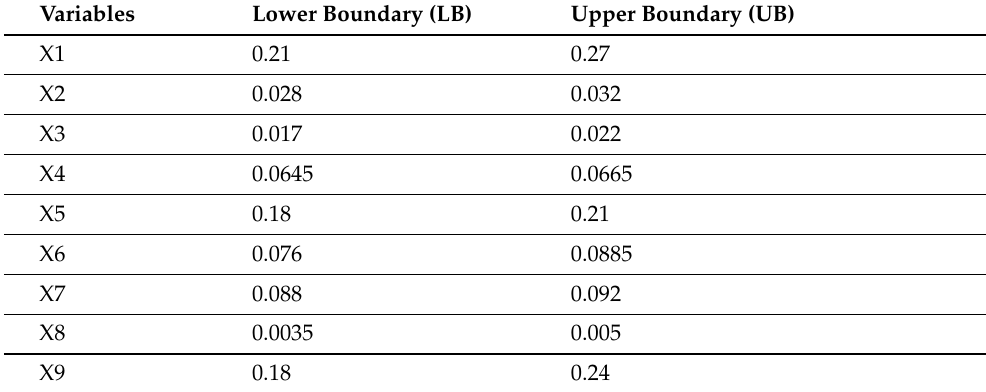
Table 5. Boundary limits of